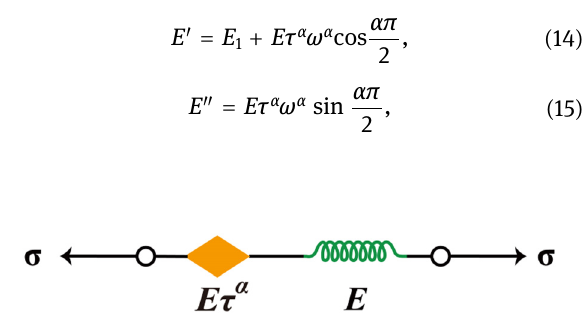
Figure 6: Kelvin model. Figure 7: Fractional Maxwell model.